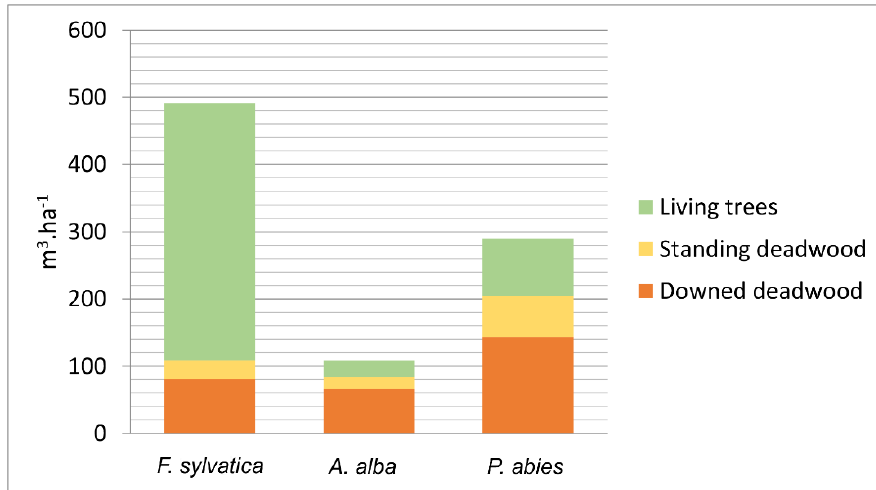
Figure A1. Volume of living trees and deadwood per tree species in Zofin according to the 2012 census.